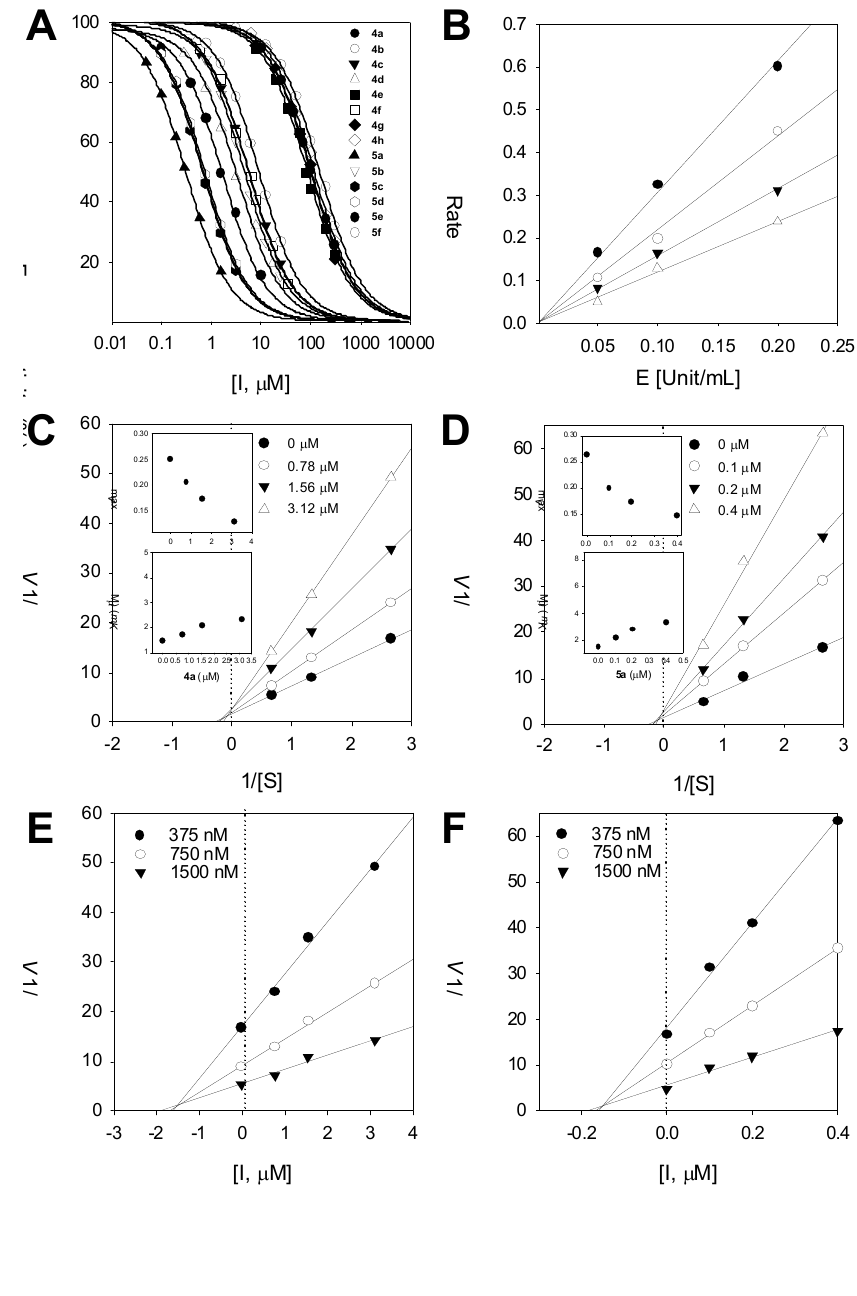
Figure 2. ( A ) Effect of compounds 4a – 5f on the hydrolytic activity of BACE1. ( B ) The hydrolytic activity of BACE1 as function of enzyme concentrations at different concentrations of compound 5a . ( C and F ) Mechanistic analysis of the inhibition of BACE1 by sulfonamide chalcones 4a and 5a . ( C and D ) Lineweaver-Burk plots for the inhibition of compounds 4a and 5a on the hydrolytic activity of BACE1. (Inset) K as a function of the concentrations of 4a and 5a . Dependence of the values of V concentration of 4a and 5a . ( E and F ) Dixon plots for the inhibition of compounds 4a and 5a on BACE1 catalyzed proteolysis of